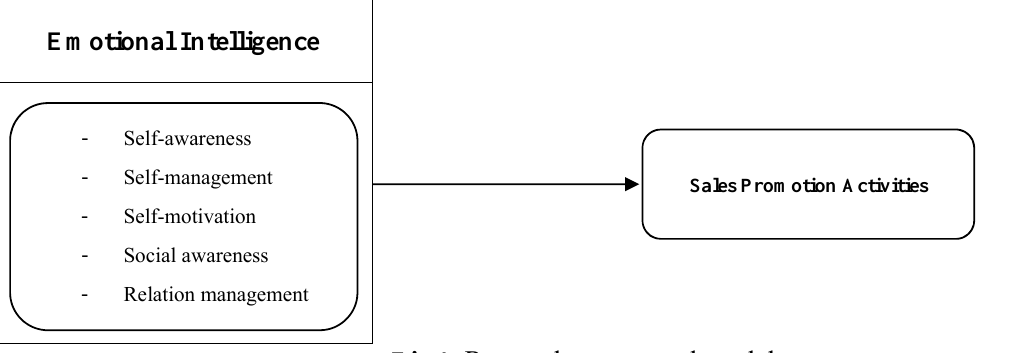
Fig.1. Research conceptual